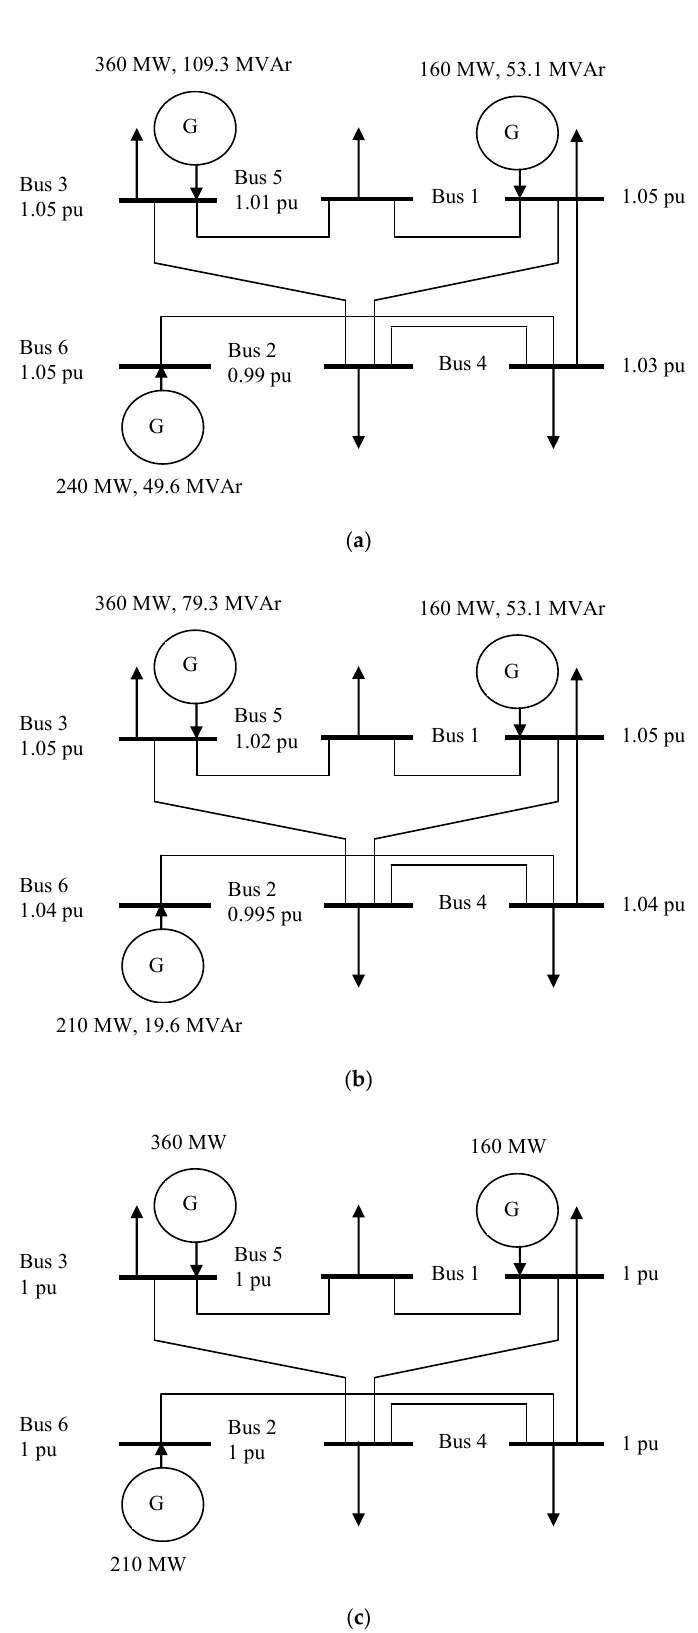
Figure 5. Structure of 6-bus network that resulted from applying the proposed problem in the last year by using ( a ) NACTEP, ( b ) LACTEP, and ( c ) DCTEP.